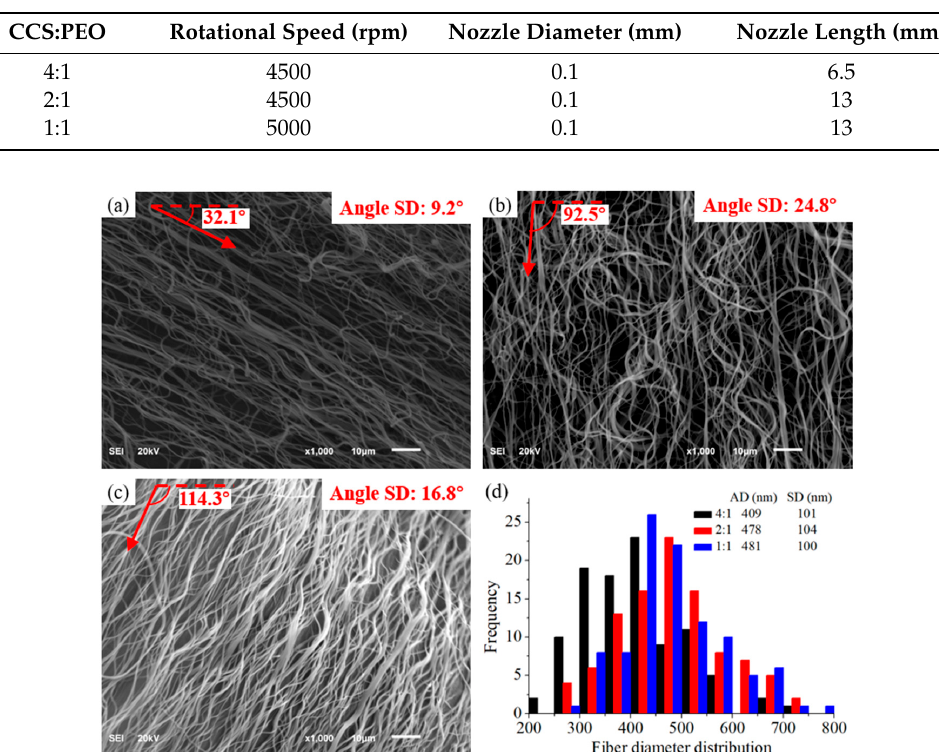
Figure 4. SEM images of nanofibers of different CCS/PEO ratios with corresponding average alignment angles and angle standard deviation (SD). ( a ): 4:1; ( b ); 2:1; ( c ): 1:1; ( d ): fiber diameter distributions of these nanofibers.